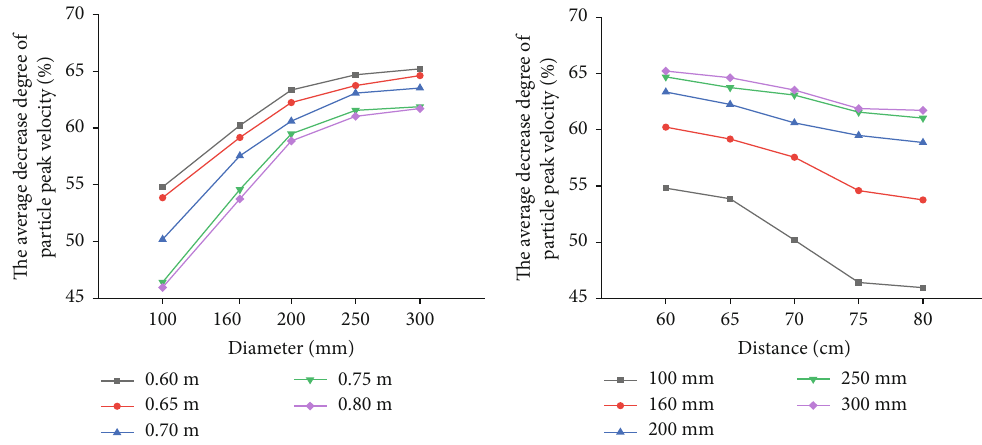
Figure 25: The in fl uence of diameter and distance on the average decrease of peak velocities.